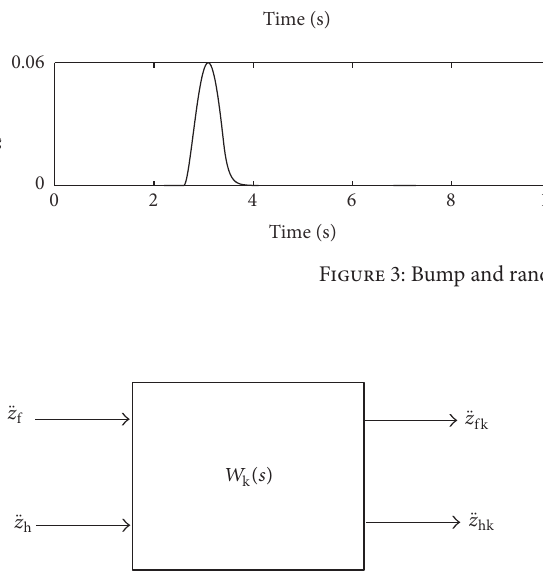
Figure 4: Block diagram of the frequency weighting.